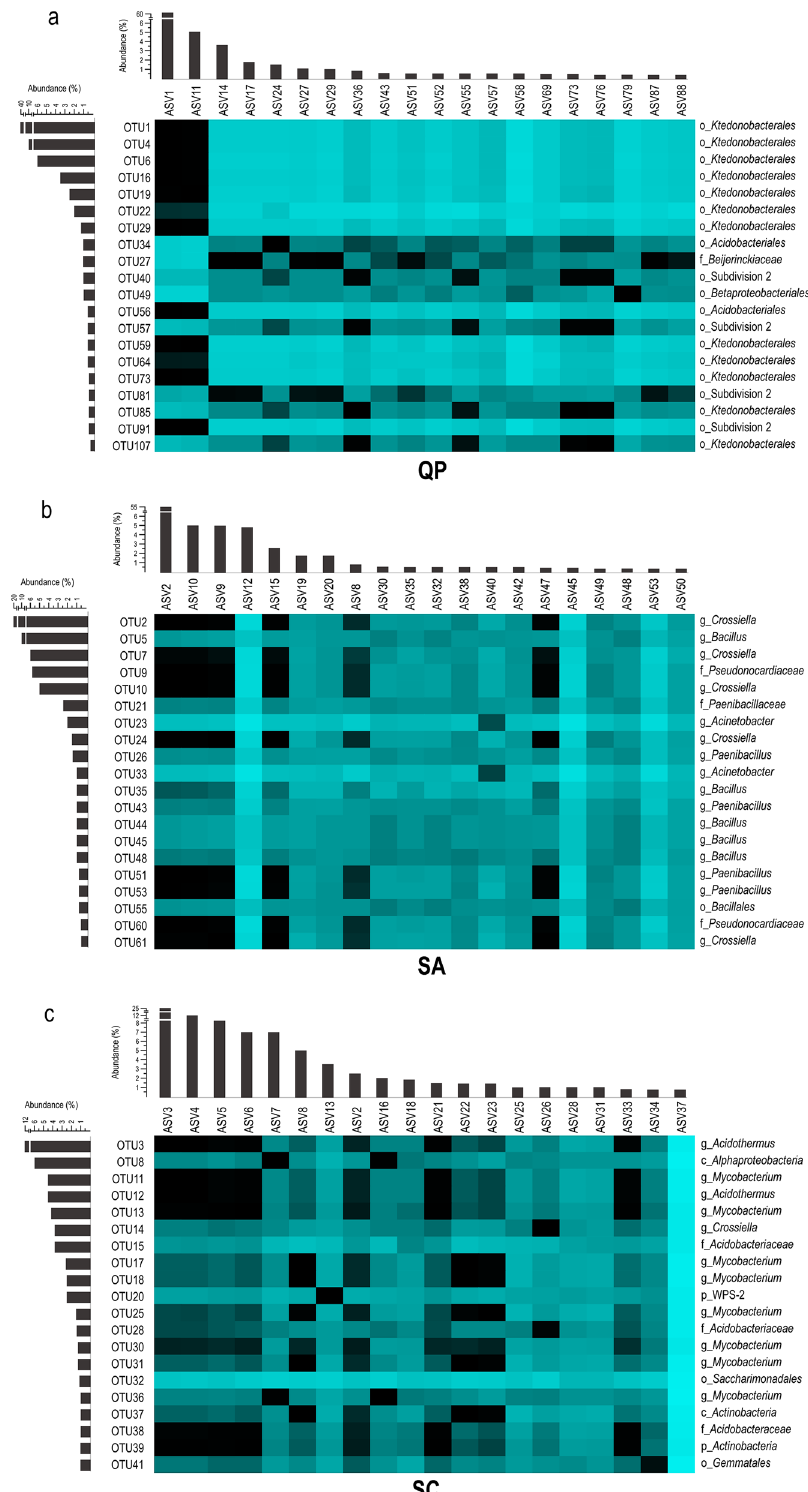
Figure 3. Heat maps showing the nucleotide similarity among the 20 most abundant ASVs and OTUs found in QP ( A ), SA ( B ) and SC ( C ) microbial communities. The green graduation levels refer to a minimum value of 50% and a maximum value of 100% of nucleotide identity. The bars in grey show the relative abundance of the reported ASV and OTU within each community. The SILVA-based taxonomy affiliation of the OTUs is indicated as follows, p = phylum, c = class, o = order, f = family, g = genus. Primer-E v7 software (www.prime r-e.comww w.prime r-e.com) was used to create the heat maps showing the percent nucleotide similarity between ASVs and OTUs that was calculated through multiple sequence alignments with Clustal Omega (https ://www.ebi.ac.uk/ Tools /msa/clust